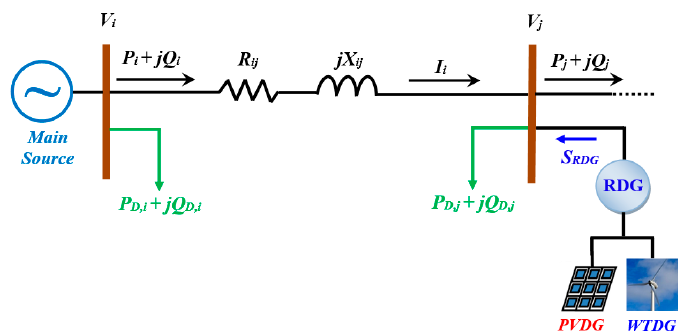
Figure 4. Modeling the distribution line with the presence of RDG sources.